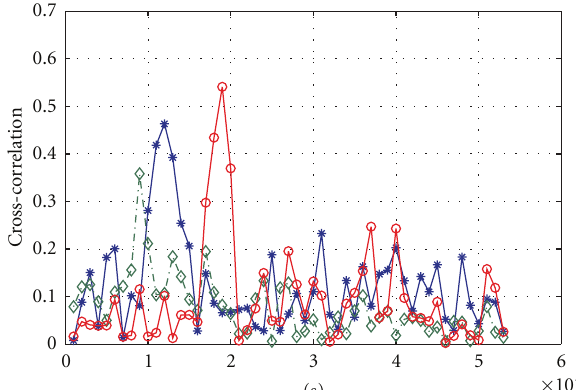
Figure 13: The cross-correlation among the eigenvectors of signal subspace after applying proposed compensation.